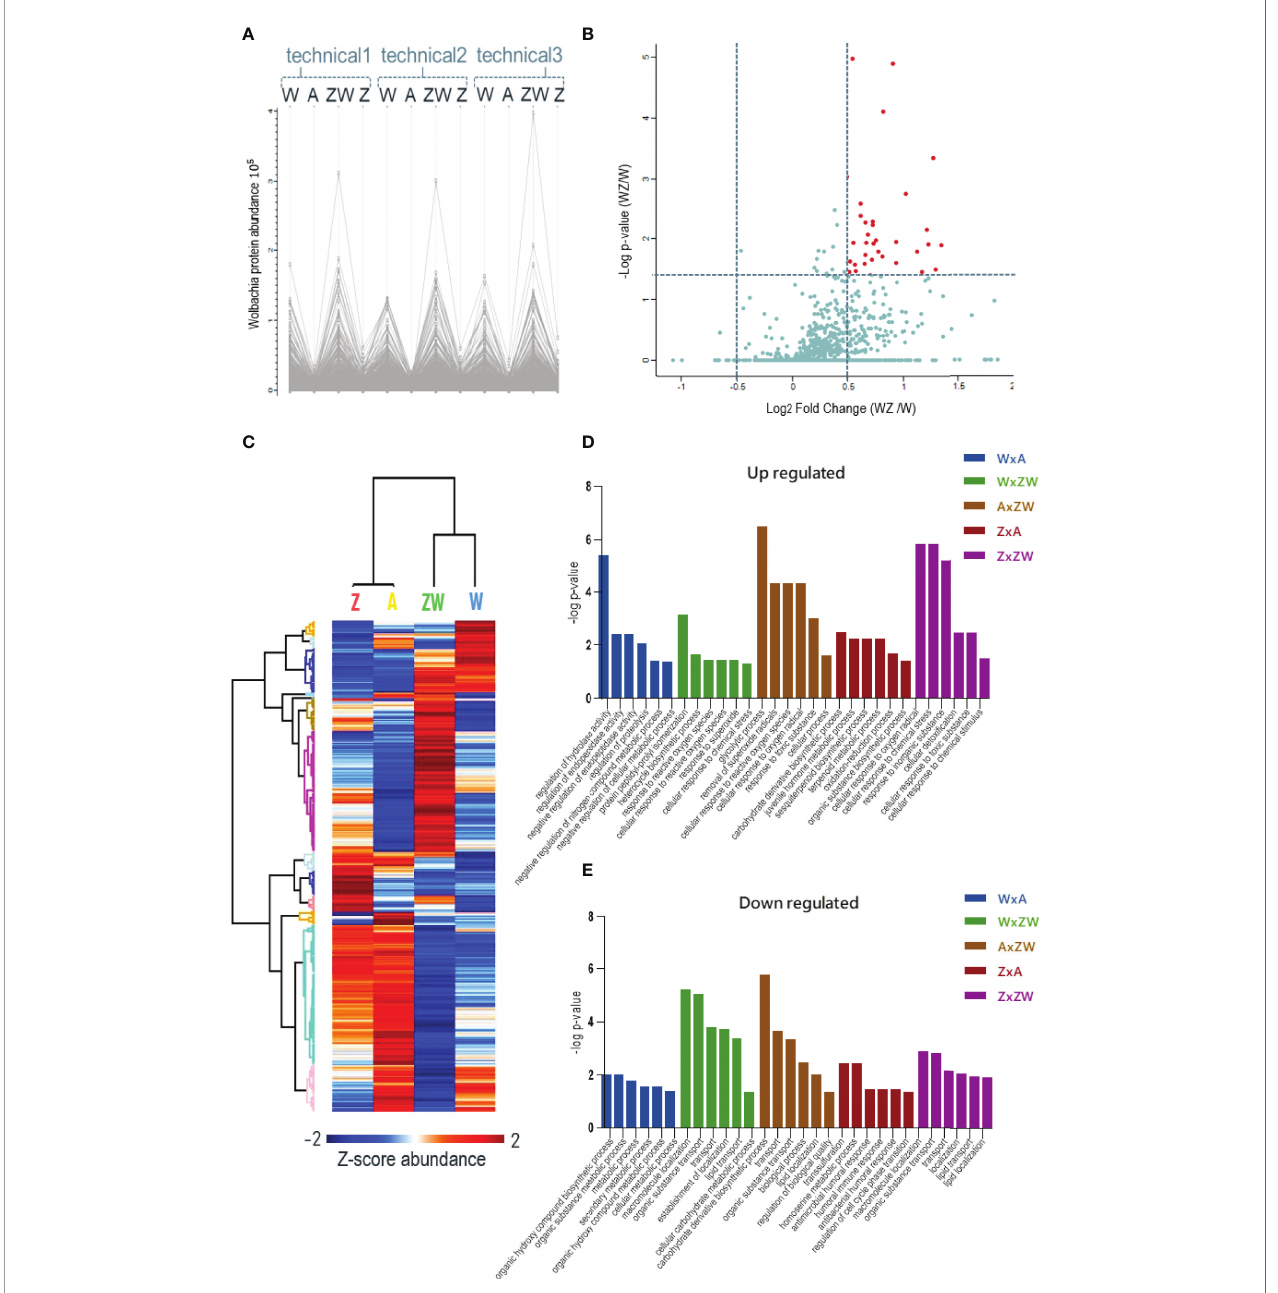
FIGURE 2 | Quantitative proteomics data. (A) Abundance chart of the three replicates of identi fi ed Wolbachia pipientis proteins. High expression is observed in the W and ZW samples, showing that it is possible to compare the expression of proteins by the relative quanti fi cation of the iTRAQ; (B) Volcano plot of Wolbachia proteins comparing WZ/W. The red dots represent upregulated proteins; (C) Heatmap of all Ae aegypti identi fi ed proteins that were upregulated (red) or downregulated (blue) during the comparison between control, monoinfected, and coinfected samples; (D) Mainly upregulated pathways statistically relevant in each condition comparison. (E) Mainly downregulated pathways statistically relevant in each condition